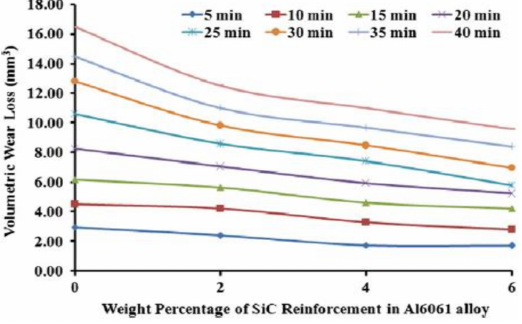
Figure 17. The wear (volumetric loss) of cast Al6061 alloy with increase in % of SiC-reinforced composites